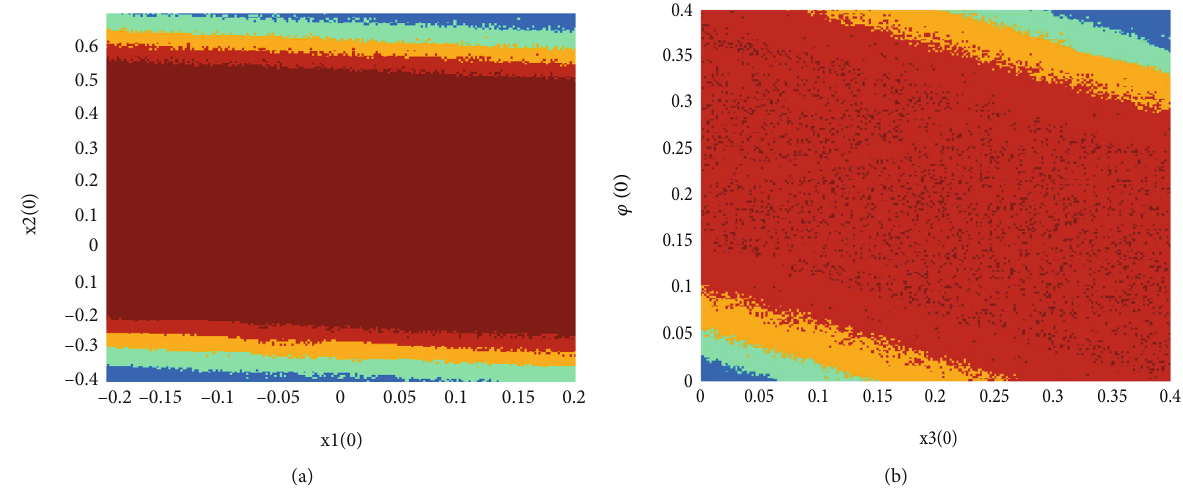
= s = s = 0 , s = 7 , s = 1 : 75 , s = − 1 : 1 , s = − 1 : 3 , s = 1 : 1 , s = 0 : 85 , a = 20 , 11 12 21 13 22 23 31 32 33 ð 0 Þ = 0 : 1 and φ ð 0 Þ = 0 : 3 and (b) the attractive basin in 3